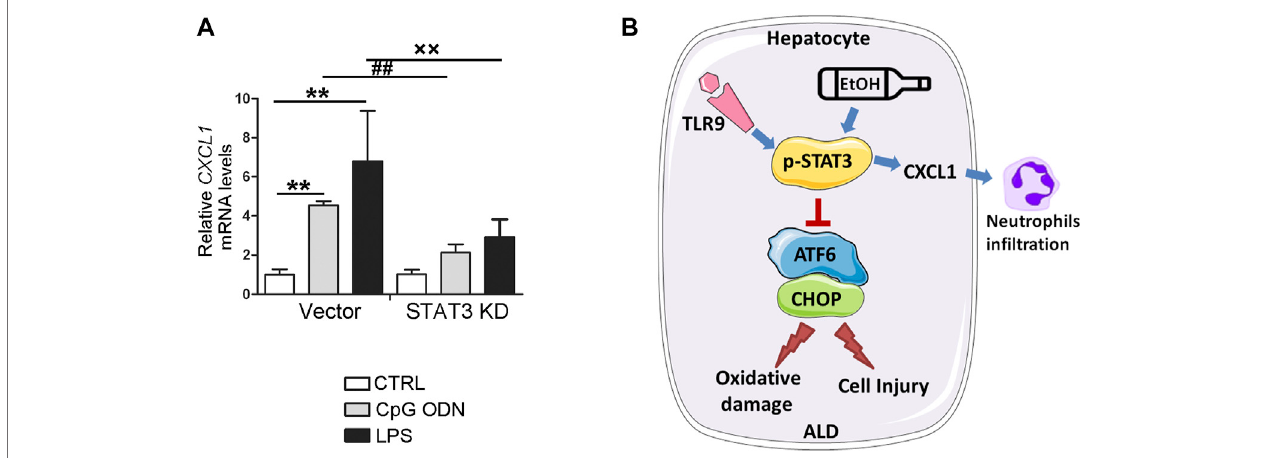
FIGURE8| STAT3positivelycontrol CXCL1 expressioninAML12cells. (A) Relative CXCL1 mRNAlevelsin STAT3 knockdownAML12cells.** p < 0.01vs.Control cells; ## p < 0.01 vs. CpG ODN treated cells; ×× p < 0.01 vs. LPS treated cells. (B) Summarized Figure of this study.